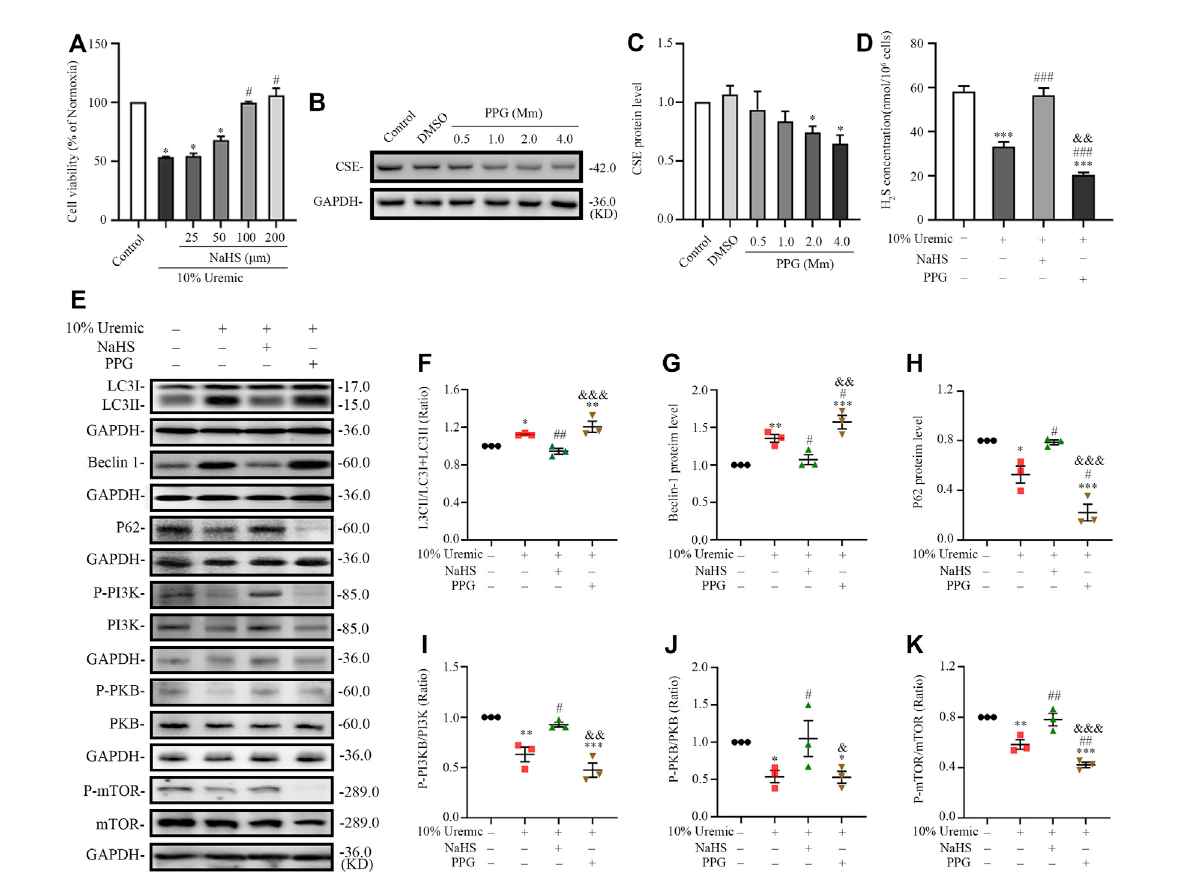
FIGURE 7 NaHSinhibits uremicserum-induced overactive autophagyinH9C2cardiomyocytes,whereasde fi ciency ofH 2 Sfurtheractivatesthese effects. (A) Cell viability ismeasuredusingtheCCK-8assay,with n =3pergroup. (B) RepresentativeWesternblotimagesofinhibitionofPPG onCSEprotein levels inH9C2cardiomyocytes. (C) Quanti fi cationoftheCSE proteinlevels inthedifferentconcentrationsofPPG inH9C2 cardiomyocytes,with n = 5 per group. (D) Quanti fi cation of H 2 S concentration in four groups of H9C2 cardiomyocytes, with n = 3 per group. (E) Representative Western blot images of LC3, becline-1, P62 p-PI3K/PI3K, p-PKB/PKB, and p-mTOR/mTOR in four groups of H9C2 cardiomyocytes. (F – H) Quanti fi cation of the LC3II/LC3(I + II) ratio, becline-1 protein levels, and p62 protein levels in the four groups of H9C2 cardiomyocytes, with n = 3 per group. (I – K) Quanti fi cation of the p-PI3K/PI3K, p-PKB/PKB, and p-mTOR/mTOR in four groups of H9C2 cardiomyocytes, with n = 3 per group. Data are representedasMean±SEM.* p < 0.05,** p < 0.01,*** p < 0.001vs.controlgroup; # p < 0.05, ## p < 0.01, ### p < 0.001vs.10%uremicserumgroup; & p < 0.05, && p < 0.01, &&& p < 0.001 vs. 10% uremic serum + NaHS